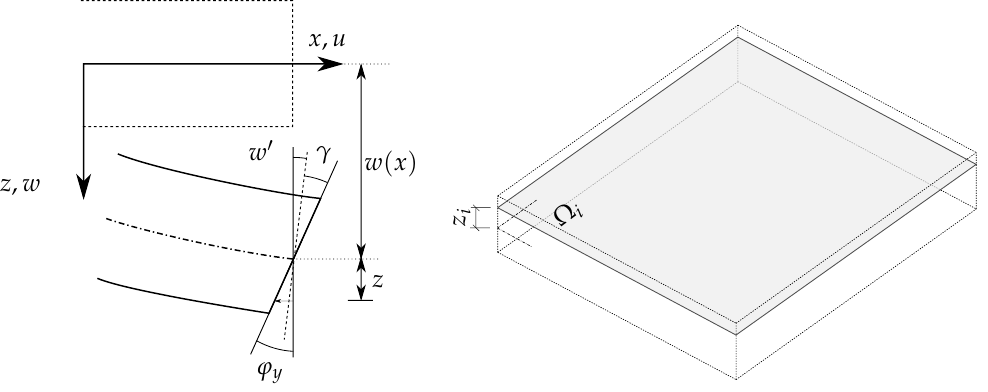
Figure 5. Graphical representation of Mindlin plate